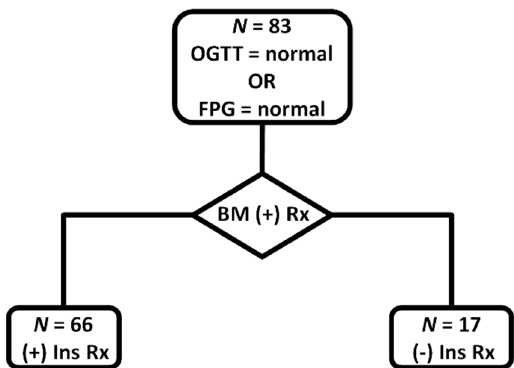
Figure 1. Flowchart of the glycemic management for the pregnant women that were studied; OGTT: oral glucose tolerance test; FPG: fasting plasma glucose; BM (+) Rx: betamethasone treatment; (+) Ins